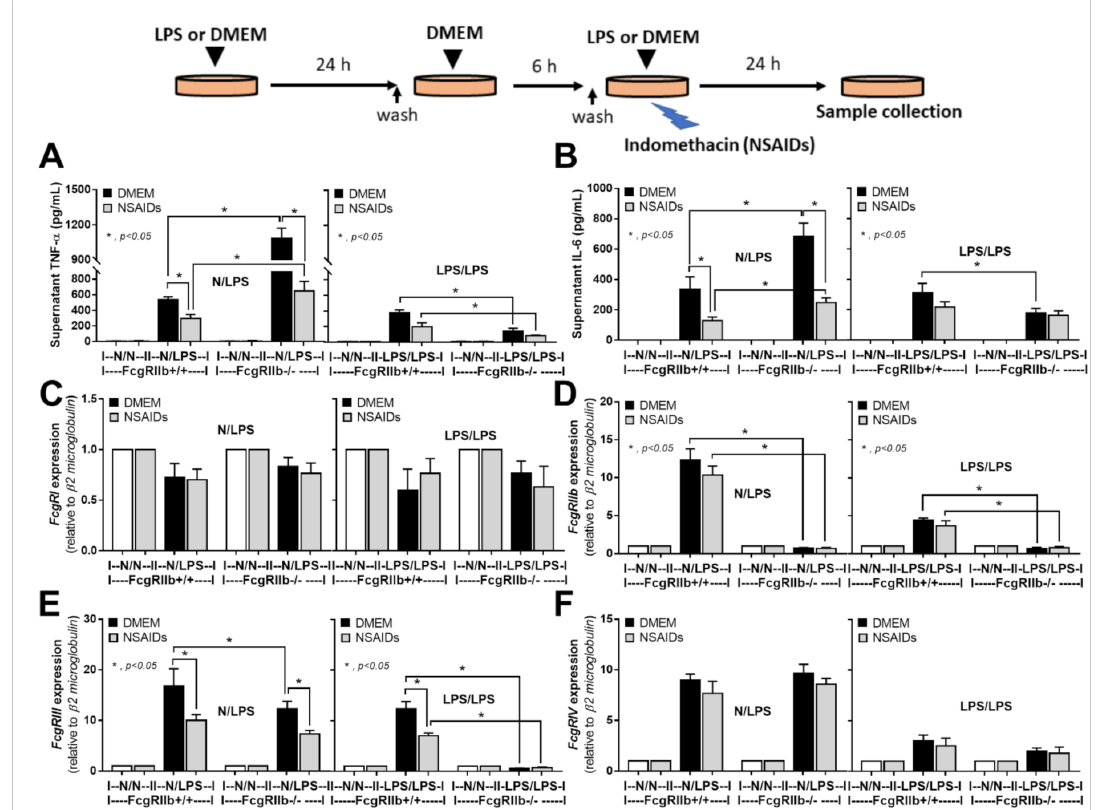
Figure 10. Schema of the in vitro experiments (upper part of figure) and the characteristics of macrophages from FcgRIIb-/- lupus mice and wild-type (FcgRIIb+/+) mice after 6 h incubation with a single lipopolysaccharide stimulation (N/LPS) or stimulation twice (LPS/LPS) with or without indomethacin (NSAIDs) as evaluated by supernatant proinflammatory cytokines ( A , B ) and the gene expression of FcgRs by quantitative polymerase chain reaction ( C–F ) were demonstrated. Independent triplicate experiments were